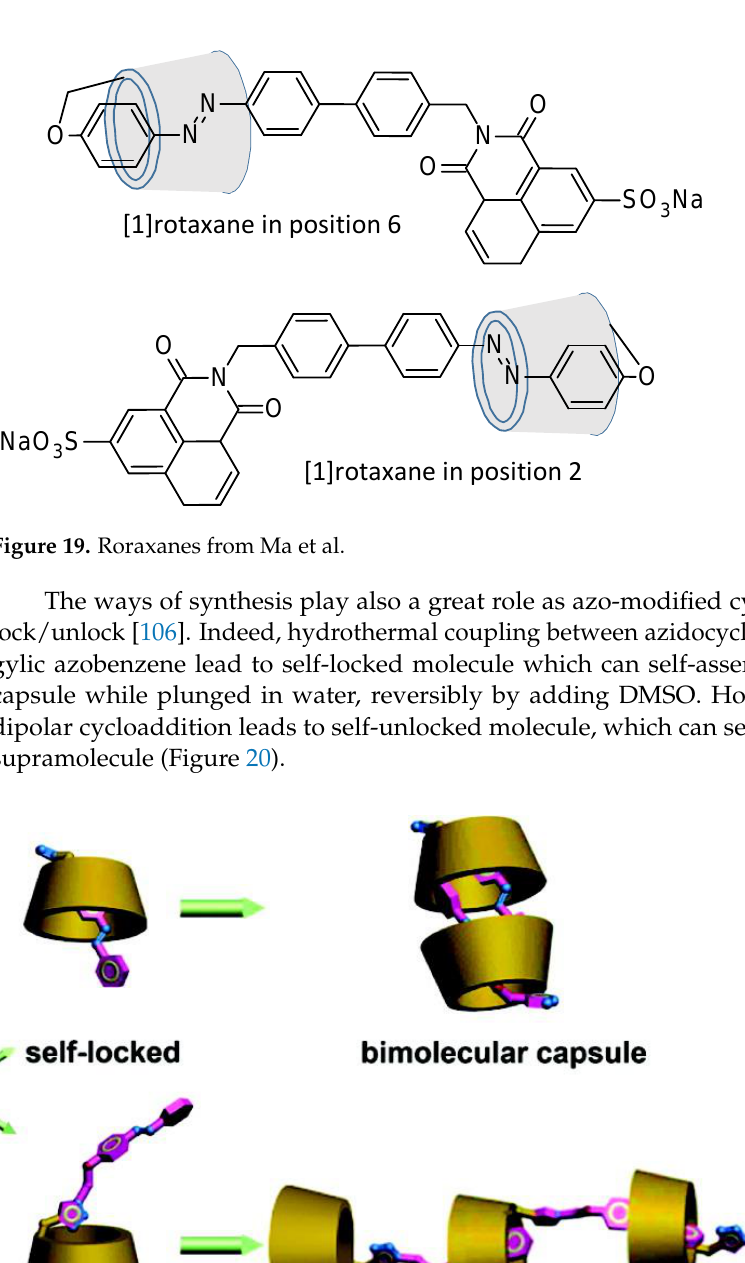
Figure 18. Ways of syntheses. a. Cs 2 CO 3 , DMF, 90 °C, 24 h ; b. (EtO) 3 P·CuI, DMF, 100 °C, 2 h.